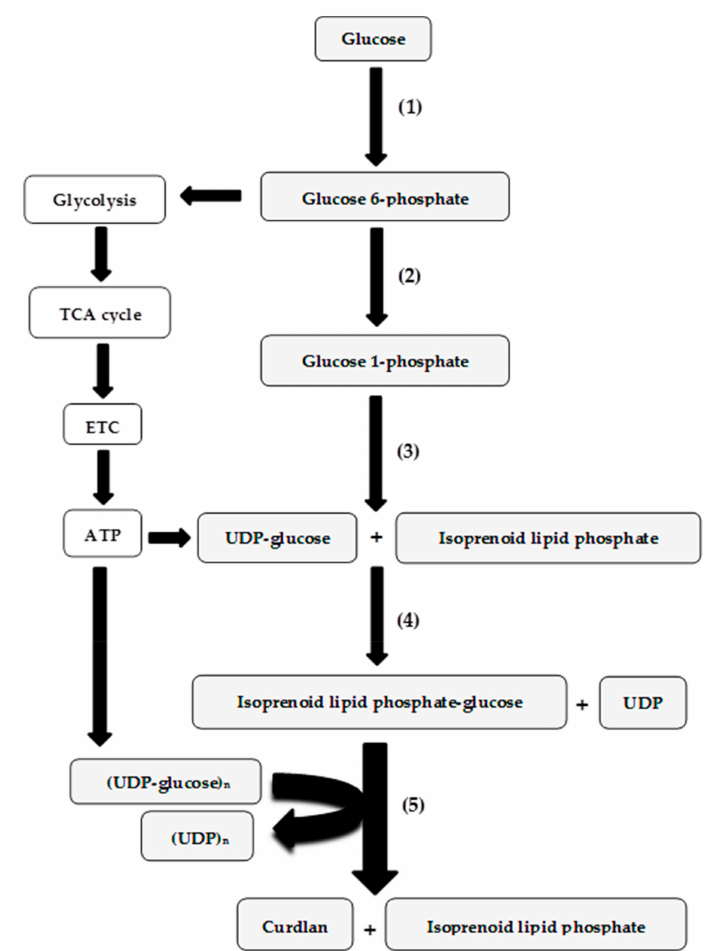
Figure1. Themetabolicpathwaysin Agrobacterium thoughttobeinvolvedincurdlansynthesis[33,40,42]. The pathway enzymes involved include (1) hexokinase, (2) phosphoglucomutase, (3) UDP-glucose pyrophosphorylase, (4) glycosyltransferase, and (5) curdlan synthase. Abbreviations: TCA cycle, tricarboxylic acid cycle; ETC, electron transport chain. The pathway for curdlan biosynthesis is shaded in grey, while the other metabolic pathways contributing to ATP formation are not